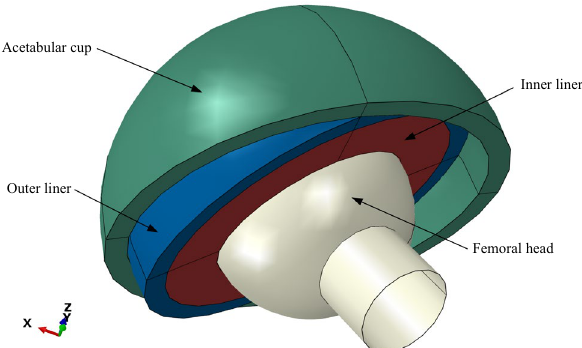
Figure 1. Geometry model of the present dual-mobility hip joint